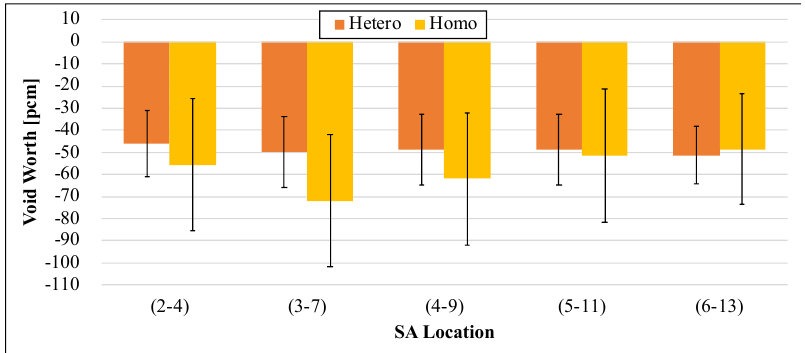
Figure 8. Void Worth Results Comparison